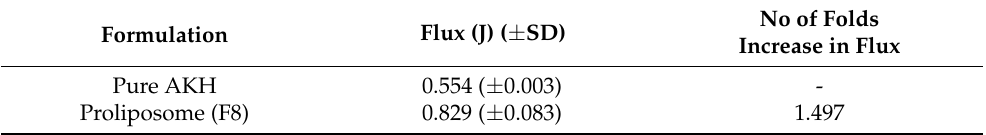
Figure 5. Average cumulative concentrations of AKH and proliposomal formulation. Table 8. Average flux (J) of AKH and proliposomal formulation ( n = 3).